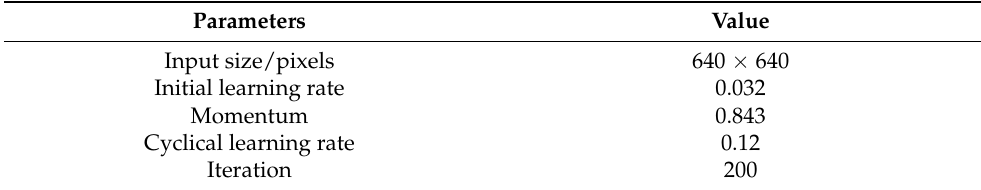
Table 2. Parameters for model